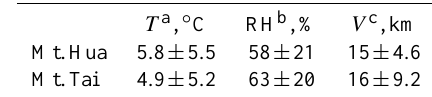
Table 1. Meteorological parameters during the sampling